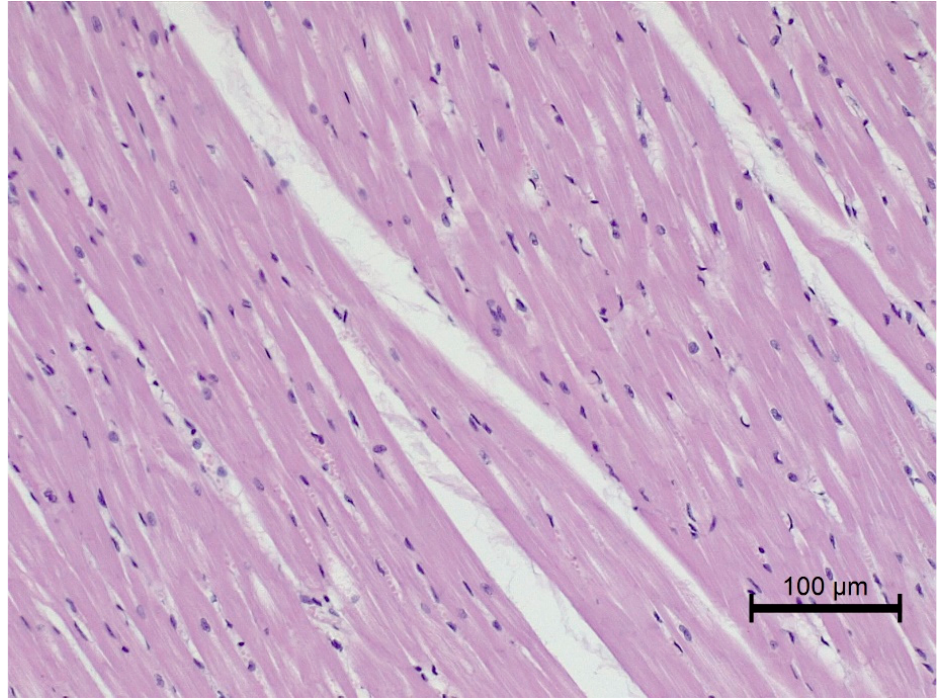
Figure 3. Microscopic image of the heart muscle specimen from a lean horse. Left ventricular wall—normal structure; HE staining; 200×.